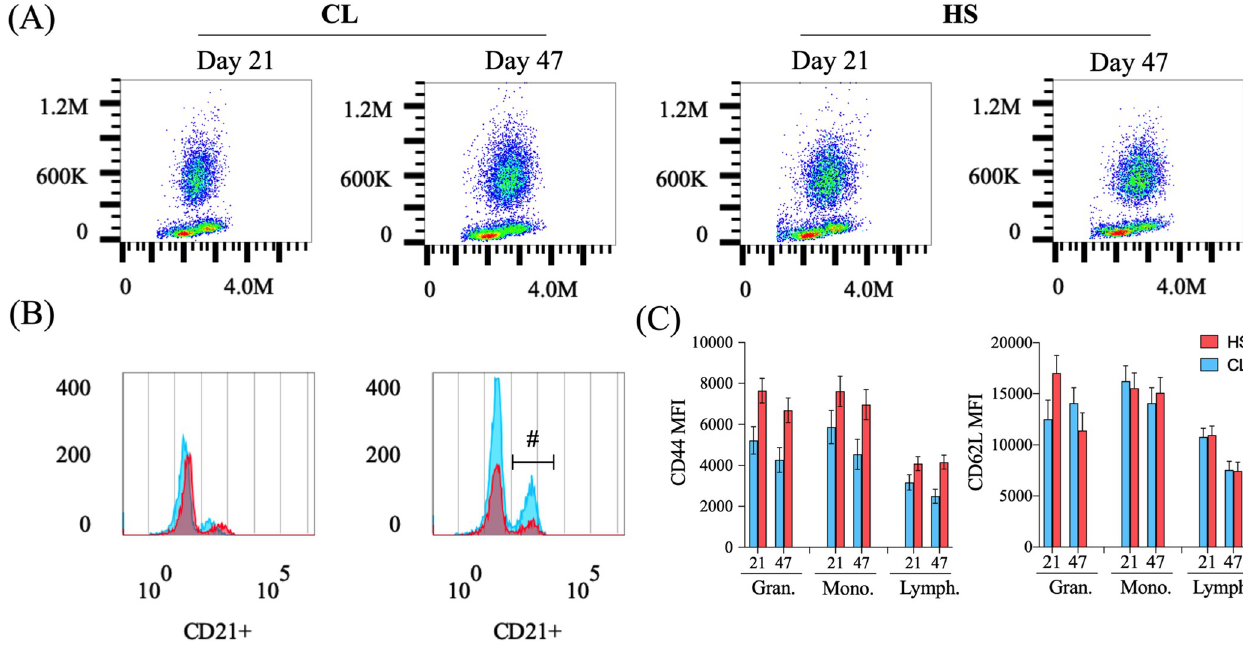
Fig 4. Flow cytometric analysis of peripheral blood leukocyte populations on postpartum d 21 and 47. ( A ) Forward versus side scatter plots displaying granulocyte, monocyte, and lymphocyte populations in dairy calves’ peripheral leukocytes, ( B ) lymphocyte CD21+ populations (B-cells) on d 21 (left plot), and d 47 (right plot) in dairy calves, and ( C ) CD44 (bottom left plot) and CD62L (bottom right plot) mean fluorescence intensity (MFI) of granulocytes, monocytes and lymphocytes per treatment in dairy calves at 21 and 47 d of age. Dairy calves were exposed to heat stress (HS; n = 6) or heat stress abatement (CL; n = 6) across pre- and postnatal phases (late gestation and pre-weaning) for a total of 102 d. Blue color denotes CL treatment, and red denotes HS treatment. There was a treatment by day interaction for CD21+ B-cells ( P = 0.02) but no interactions were found for the CD62L or CD44 expression of granulocytes, lymphocytes or monocytes ( P > 0.07). Pound sign (#) indicate tendency (0.05 < P � 0.10).